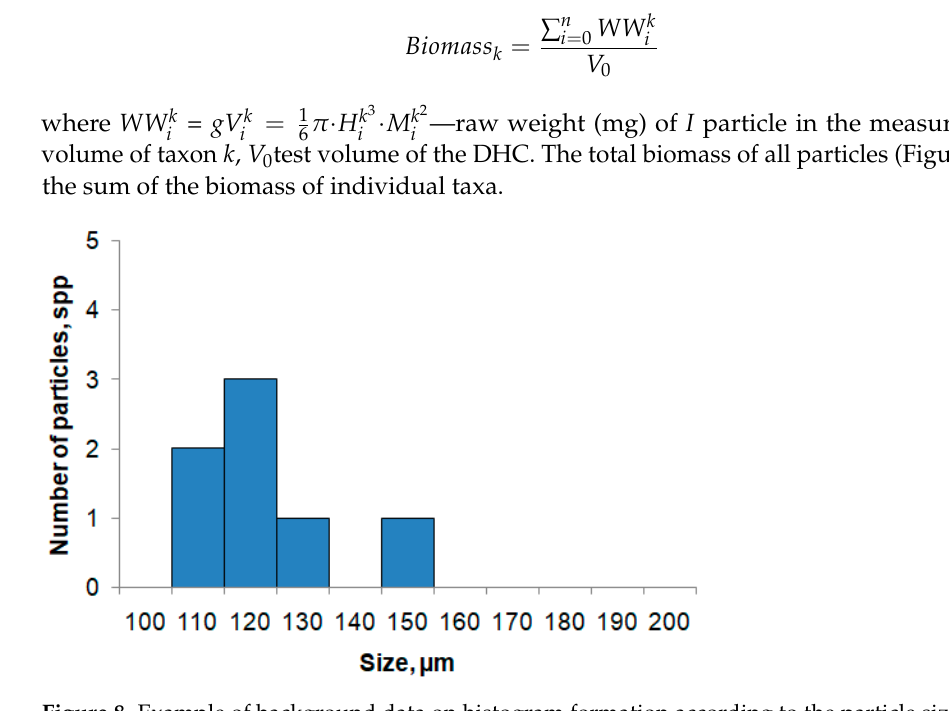
Figure 8. Example of background data on histogram formation according to the particle size of the Suspension taxon. Sailing of Ashamba research vessel to the Black Sea on 14 October 2019, station no. 3 with coordinates 44°33.8755 ′ N 37°57.1170 ′ E, submersion up to 50 m.